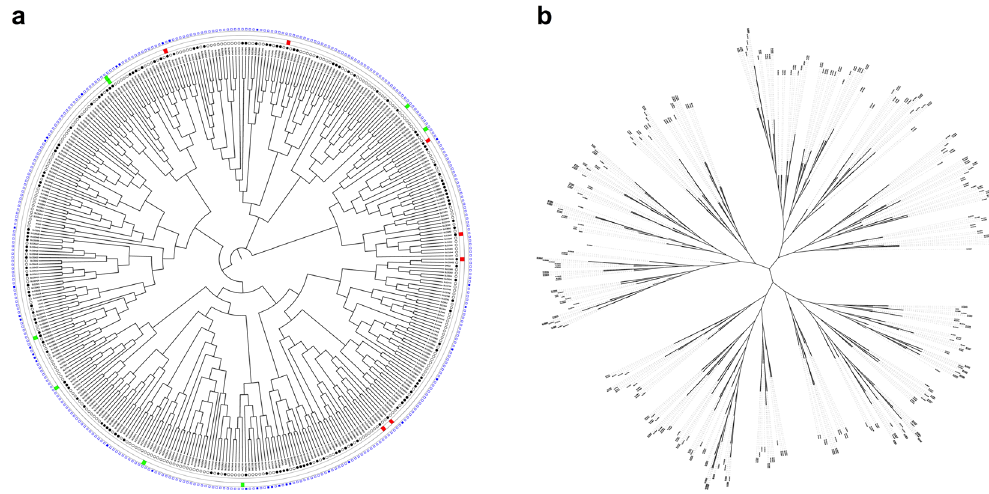
Figure 1. Subsets of SLC transporter proteins are expressed and regulated in primary human neutrophils. Scalable phylogenetic trees in both ( a ) circular and ( b ) unrooted display modes indicate evolutionary relationships between SLC transporter proteins in humans (branch lengths are not proportional to genetic distance; see Supplementary Fig. S1 for trees with proportional branch lengths). In ( a ), for primary human neutrophil expression data (inner circle), expressed proteins are marked with a black dot, whereas proteins not expressed are denoted with a white dot. For GM-CSF (second circle from centre) and TNF α (third circle from centre) regulation data, significant up-regulation of a gene is denoted with a green box, significant down- regulation is denoted by a red box, and a lack of significant change in regulation is unmarked. For human neutrophil proteomics data (outer circle), any proteins identified in one or more of the analyses are denoted with a blue box, and any not identified are denoted with a white